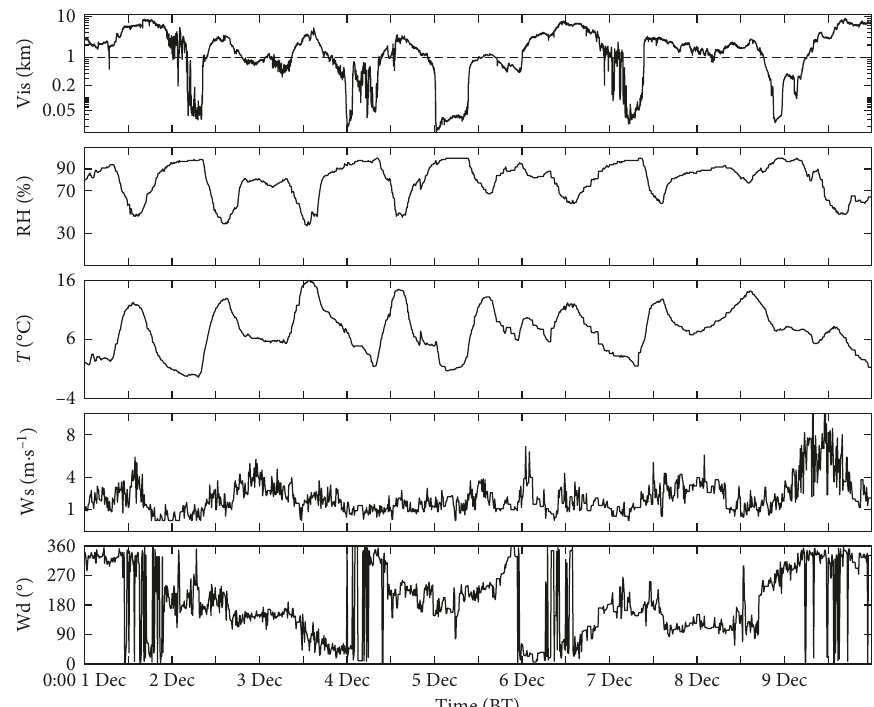
Figure 2: Temporal variation of visibility, relative humidity, temperature, wind speed, and wind direction at the Sheyang site from 1 to 9 December